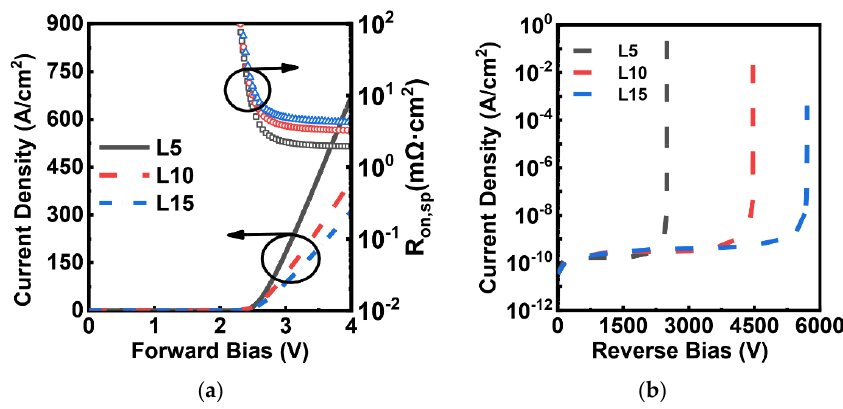
Figure 3. ( a ) Forward J-V characteristics and Ron,sp–Forward V ( b ) reverse J-V characteristics of p-NiO/Ga 2 O 3 with 5 µ m, 10 µ m, and 15 µ m drift layer thicknesses.